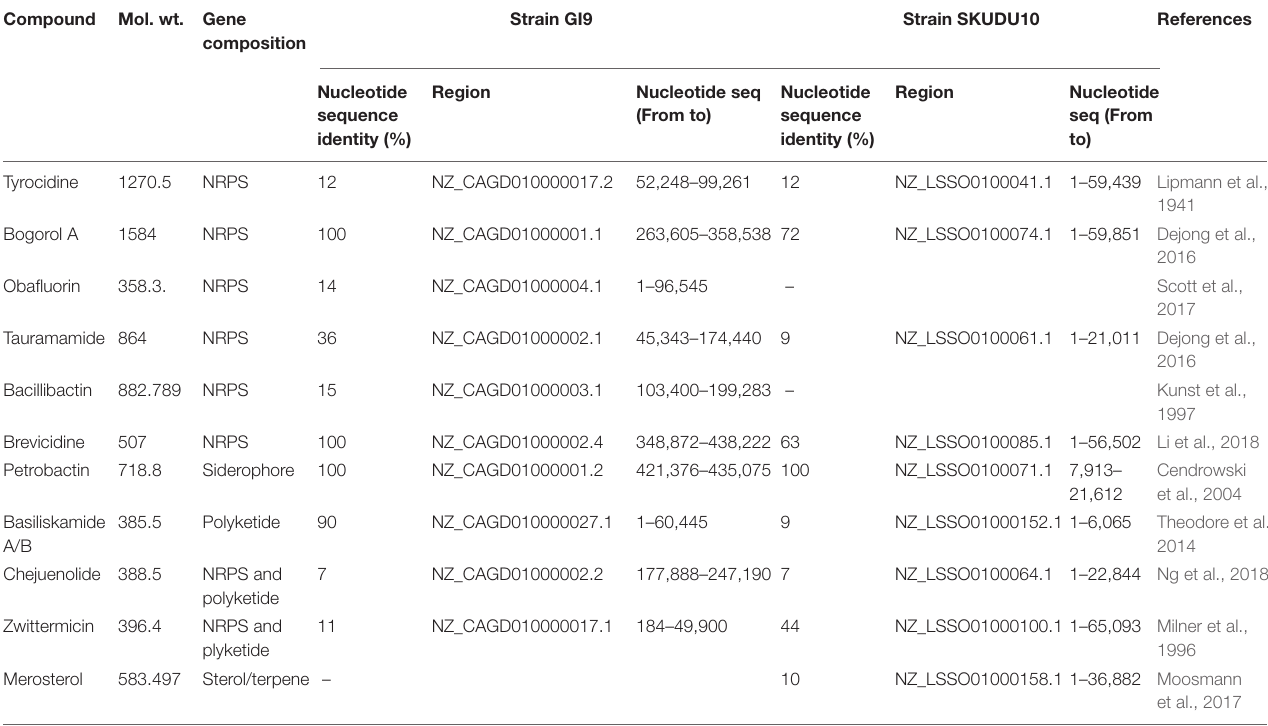
( Figure 3F ). No reduction in CFU/ml count was observed for the untreated